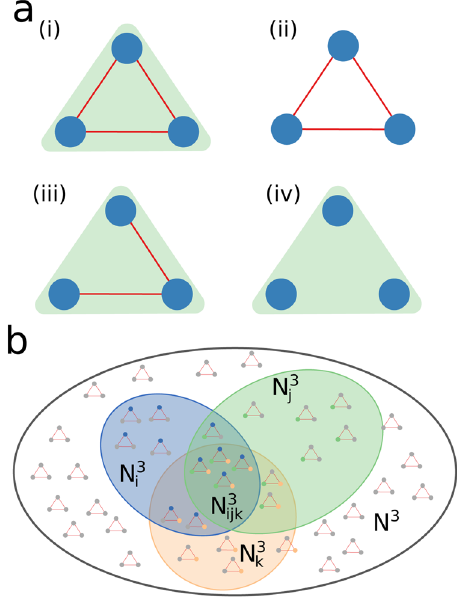
Fig. 1 A higher-order fi lter for hypergraphs. a Schematic illustration of false positives and false negatives in the investigation of statistically validated hyperlinks of size n = 3 detected in the Statistically Validated Hypergraph (SVH) compared with an approach based on statistically validated pairwise interactions. Green shaded triangles represent statistically validated hyperlinks with SVH, whereas red lines depict statistically validated pairwise interactions. Considering the various possibilities: (i) both the hyperlink and the 3-clique of pairwise interactions are validated; (ii) the SVH does not statistically validate the hyperlink whereas a 3-clique among the three nodes emerges from the validation of pairwise interactions. Taking the statistically validated pairwise overexpression as an indication of full interaction between nodes provides a conclusion on the overexpression of the hyperlink that is a false positive; (iii) and (iv) the hyperlink is statistically validated but the statistically validated pairwise links do not form a clique (i.e., detecting hyperlinks by evaluating the statistical validation of pairwise interactions would produce a false negative). b Schematic description of the SVH method for hyperlinks of size n = 3. In this example, node i is blue, node j is green, and node k is orange. The shaded areas represent the sets of hyperlinks of each node. The hyperlink { i , j , k } is occurring four times. By knowing the number of all N 3 hyperlinks of size 3 in the system, and N 3 N 3 N 3 i , j , and k number of hyperlinks including node i , j , and k respectively, our methodology allows us of the two parameters. The fi rst row of each matrix represents the to compute the probability of observing N 3 i ; j ; k occurrences (see Eq. (1) in “ Methods ” difference of the curves plotted in Fig. 2a and Supplementary